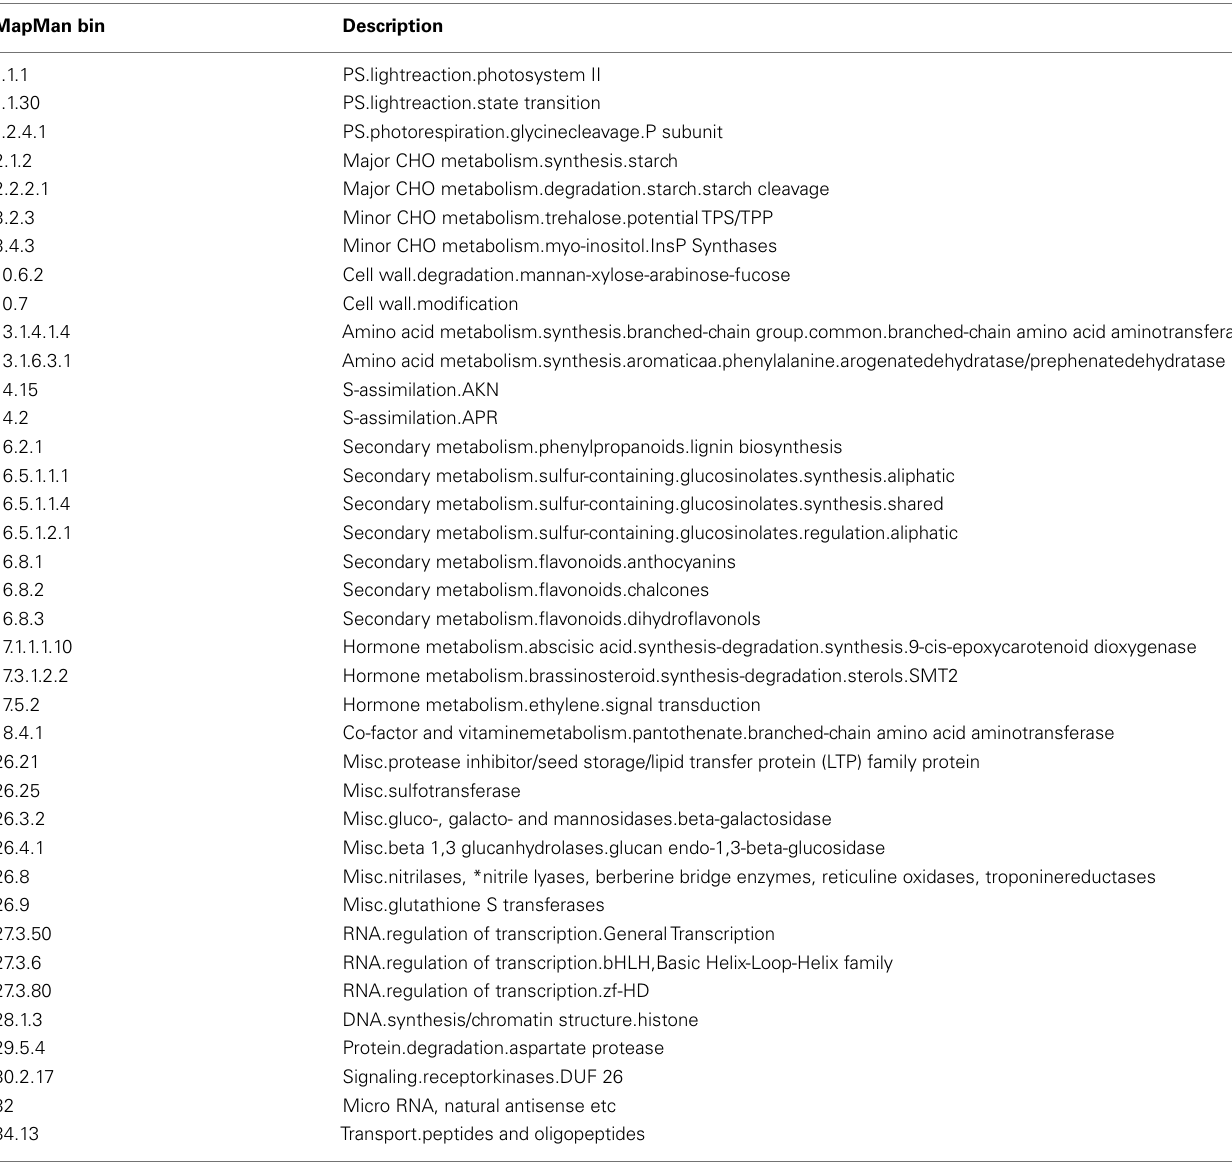
Table 1 | Overview of over-represented MapMan bins determined by an enrichment analysis using significantly contributing observations (i.e., genes) in the STATIS analysis at a significance level of